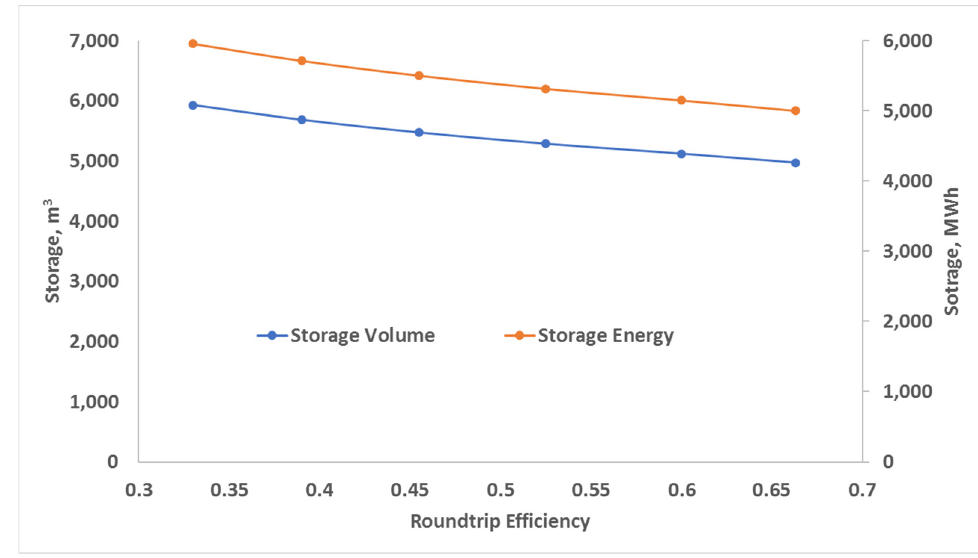
Figure 6. Effect of round-trip efficiency on the required storage capacity, in m 3 and MWh.